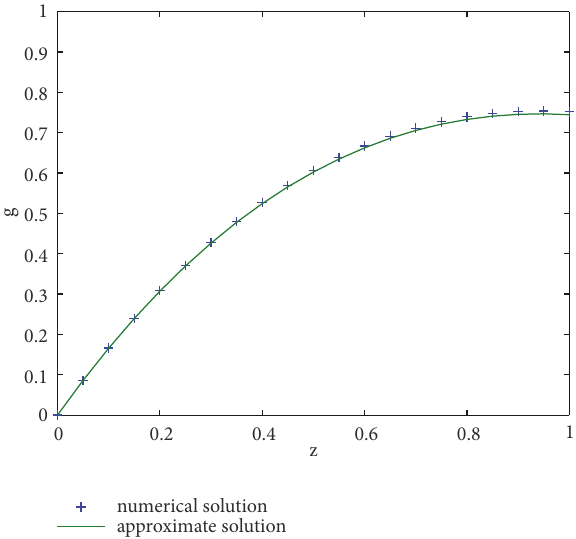
Figure9:Thecomparisonoftheresultsofapproximatesolutionand numerical solution for 𝛼 = 2.0 , 𝑛 = 1.0 , 𝑘(𝑧) = 𝑧 3 , ℎ(𝑧) = 1 − 𝑧 .